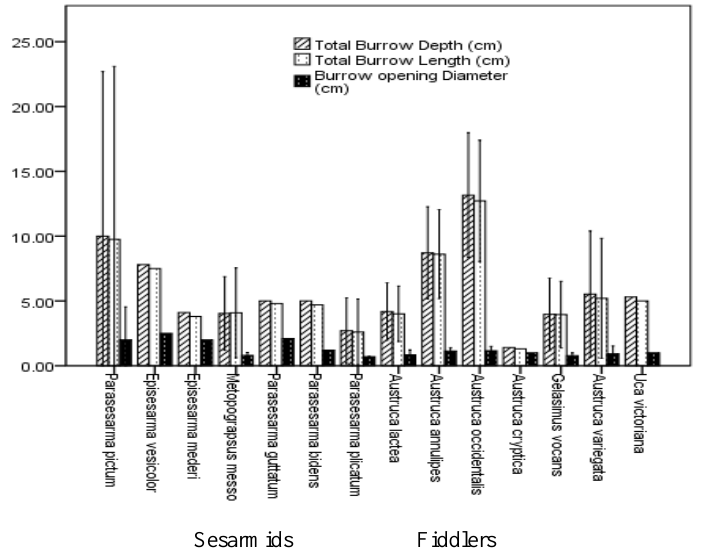
Figure 6. Crab species-specific burrow opening diameter, length and depth of burrows; values significant between crab species at 1% level.